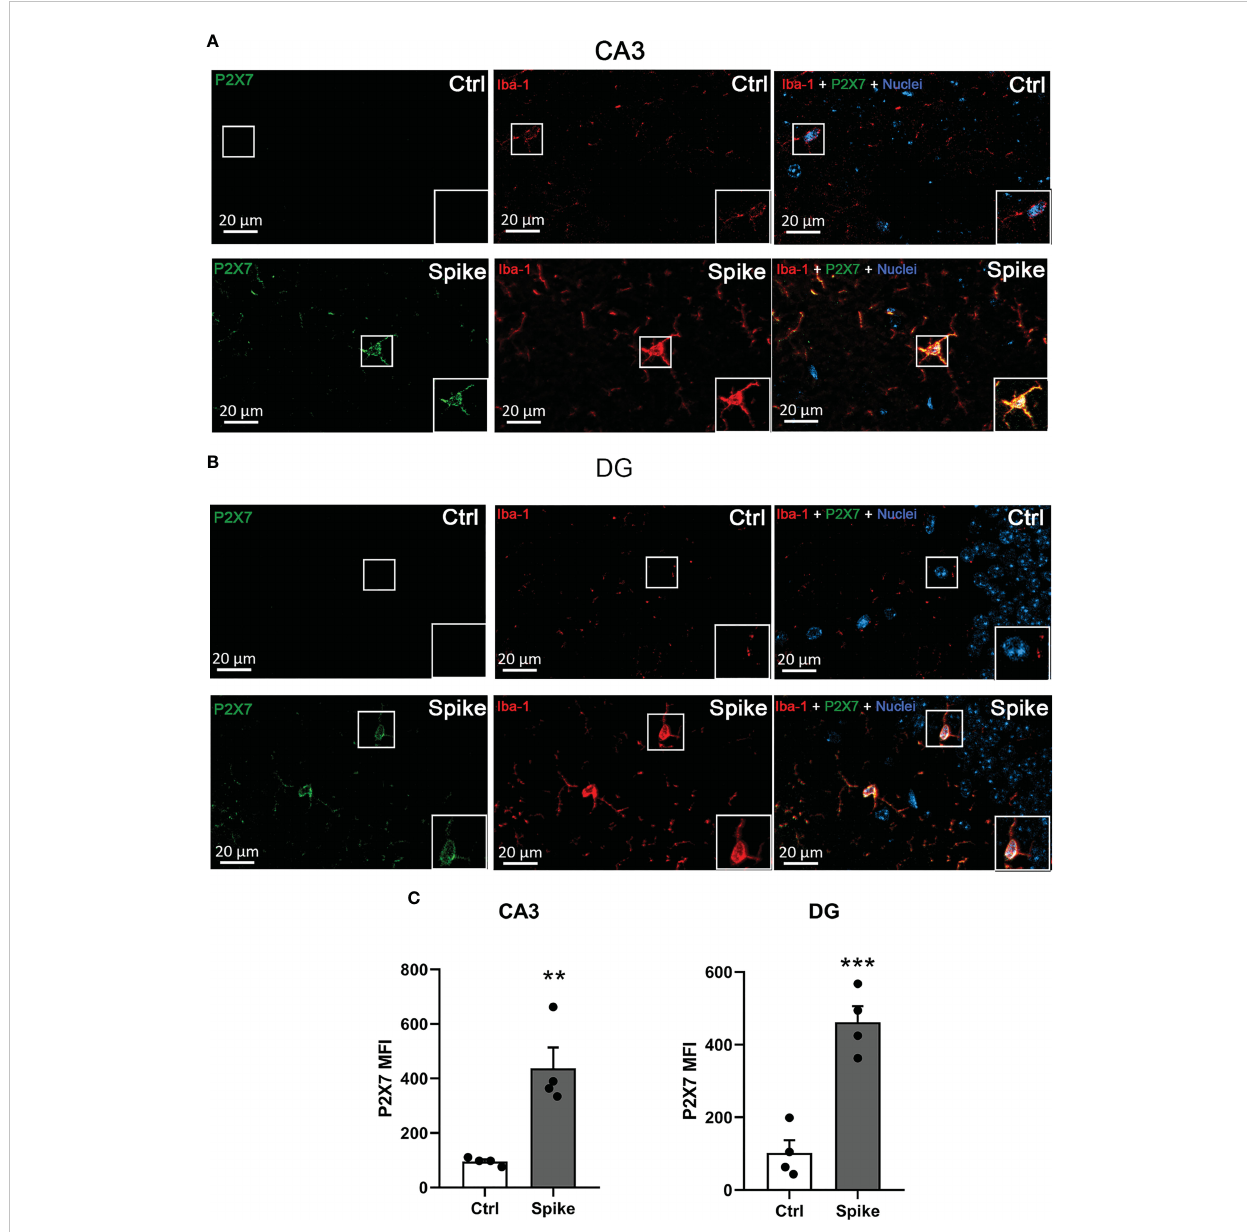
FIGURE 4 SARS − CoV − 2 spike protein increases P2X7 receptor expression in hippocampal microglial cells. Representative images of P2X7 receptor and Iba-1 immunostaining in the CA3 (A) and dentate gyrus (DG) (B) hippocampal regions of Ctrl or spike-infused mice. Scale bar = 20 m m. (C) Quanti fi cation of P2X7 receptor fl uorescence in Iba-1-positive cells from control (Ctrl) or spike-infused mice in CA3 and DG hippocampal regions. Data are expressed as mean ± SEM. Statistically signi fi cant differences between Ctrl and treated groups are represented by asterisks (**, p < 0.01; ***, p < 0.005). Student ’ s t-test (n =